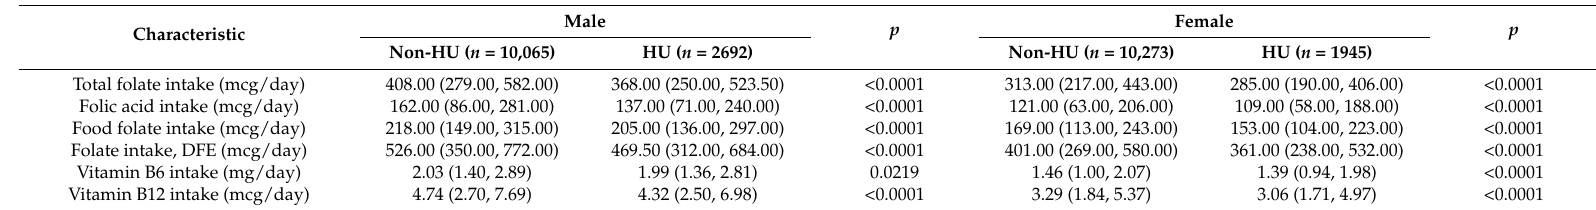
Table 3. B-vitamin intakes characteristics of participants with or without HU.